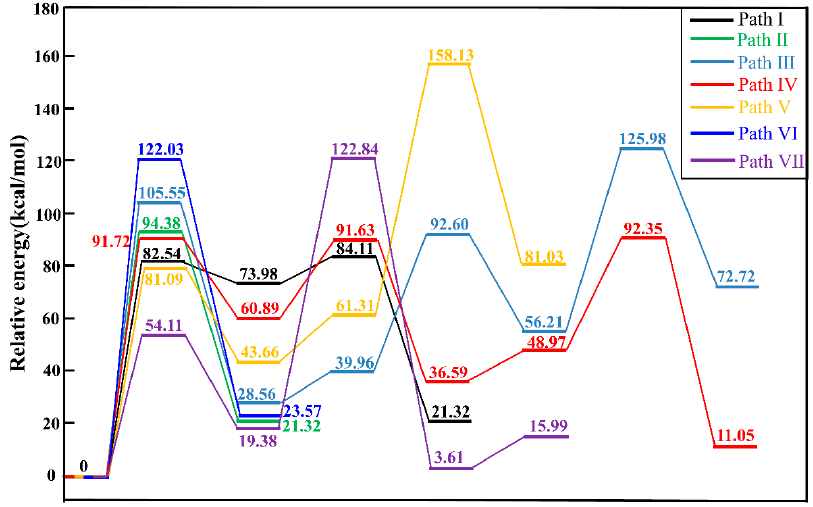
Figure 7. The potential energy diagram for the path I to path VII.